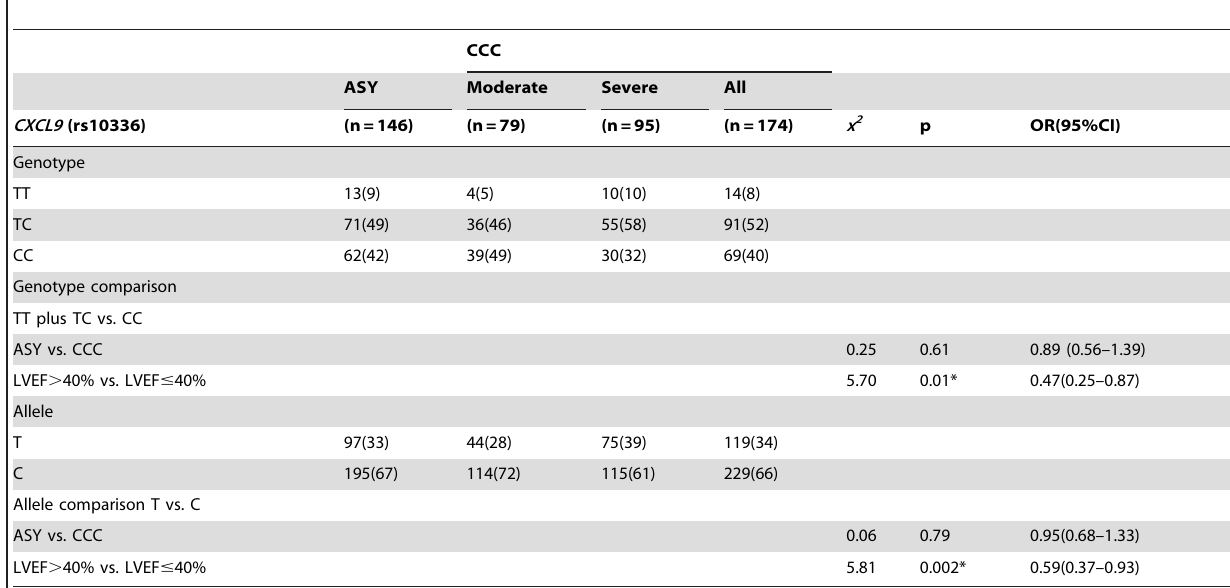
Table 2. Genotype and allele frequencies for the CXCL9 rs10336 polymorphism in patients with Chagas